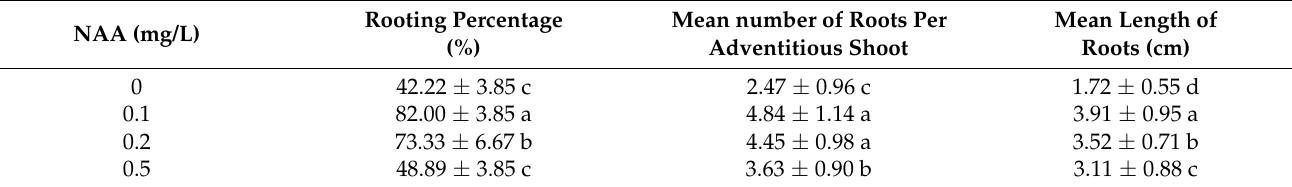
Table 11. Effect of NAA on rooting of adventitious